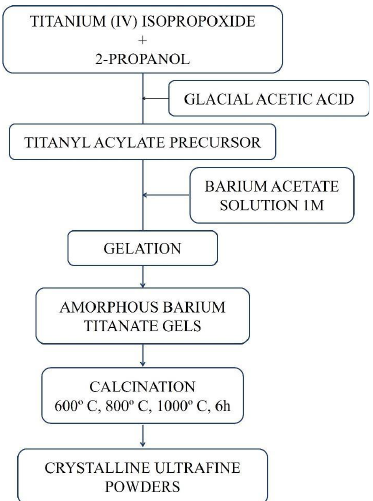
Figure 2. Diagram with the production stages of BaTiO 3 by the sol-gel method.